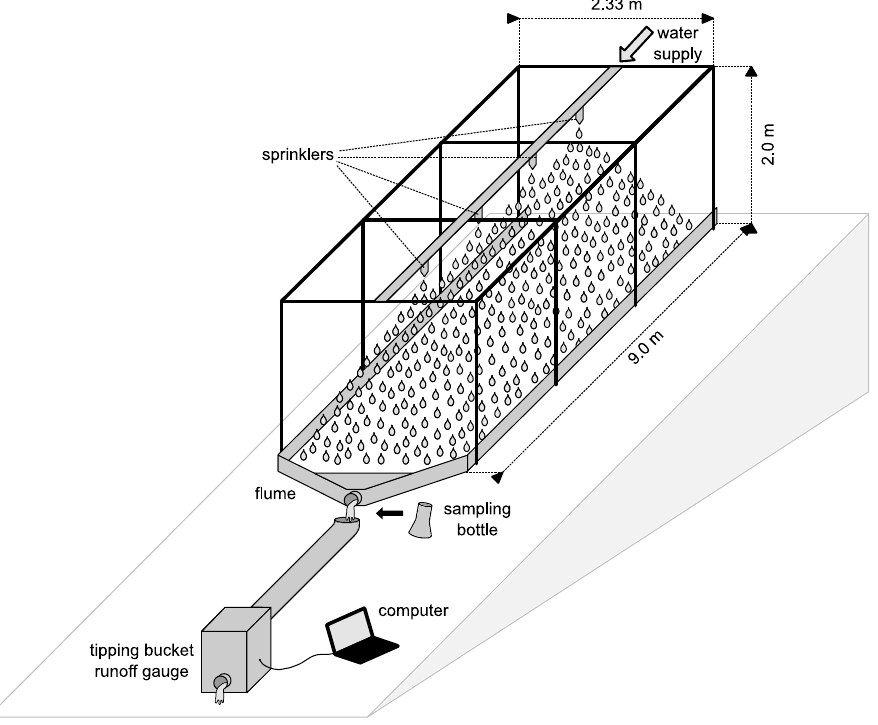
Figure 2. Scheme of the rainfall simulator and the equipment setup.